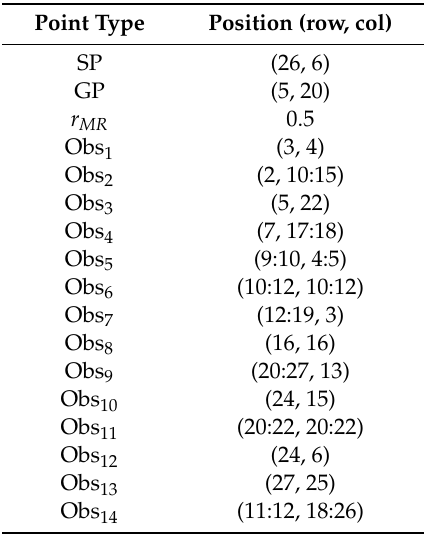
Table 2. Grid-based static environment 2 setting.